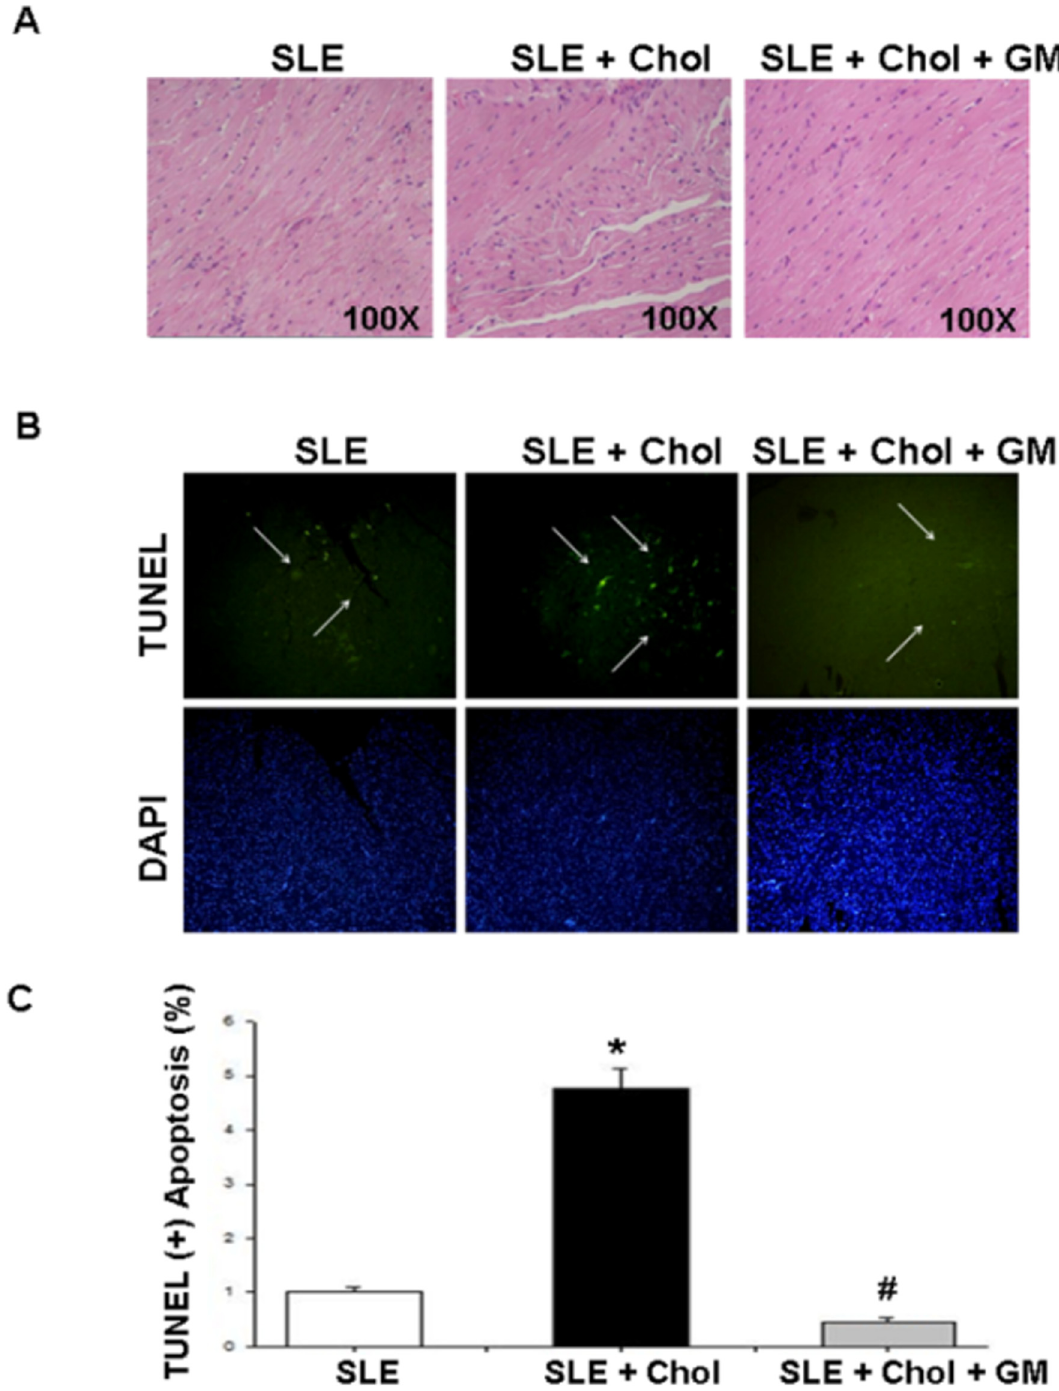
Fig 1. Cardiac histopathological changes in NZB/W F1 mice fed with different dietary supplements. (A) Histopathological analysis of cardiac tissue sections with hematoxylin and eosin staining and (B) representative stained apoptotic cells of cardiac sections from NZB/W F1 mice fed with different supplementations, as obtained by TUNEL assay. (C) Percentages of apoptotic cells were calculated. Images of myocardial architecture were magnified 100 times. Bars represent number of TUNEL-positive cells as a percentage of total number of cells (10 scope field count for each mice in each group) and values are expressed as mean ± SD. * and # indicate significant differences relative to SLE and SLE + cholesterol groups, respectively. Similar results were obtained in triplicate experiments. SLE: systemic lupus erythematosus; Chol: cholesterol; GM: Gentiana macrophylla Pall.